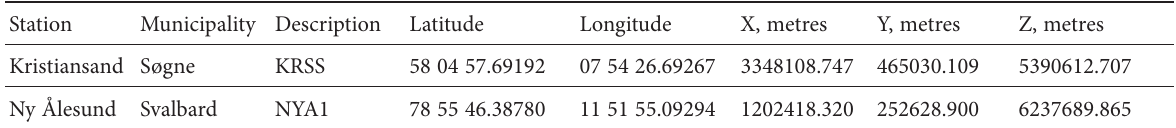
Table 1. The coordinates of the chosen CPOS station Station